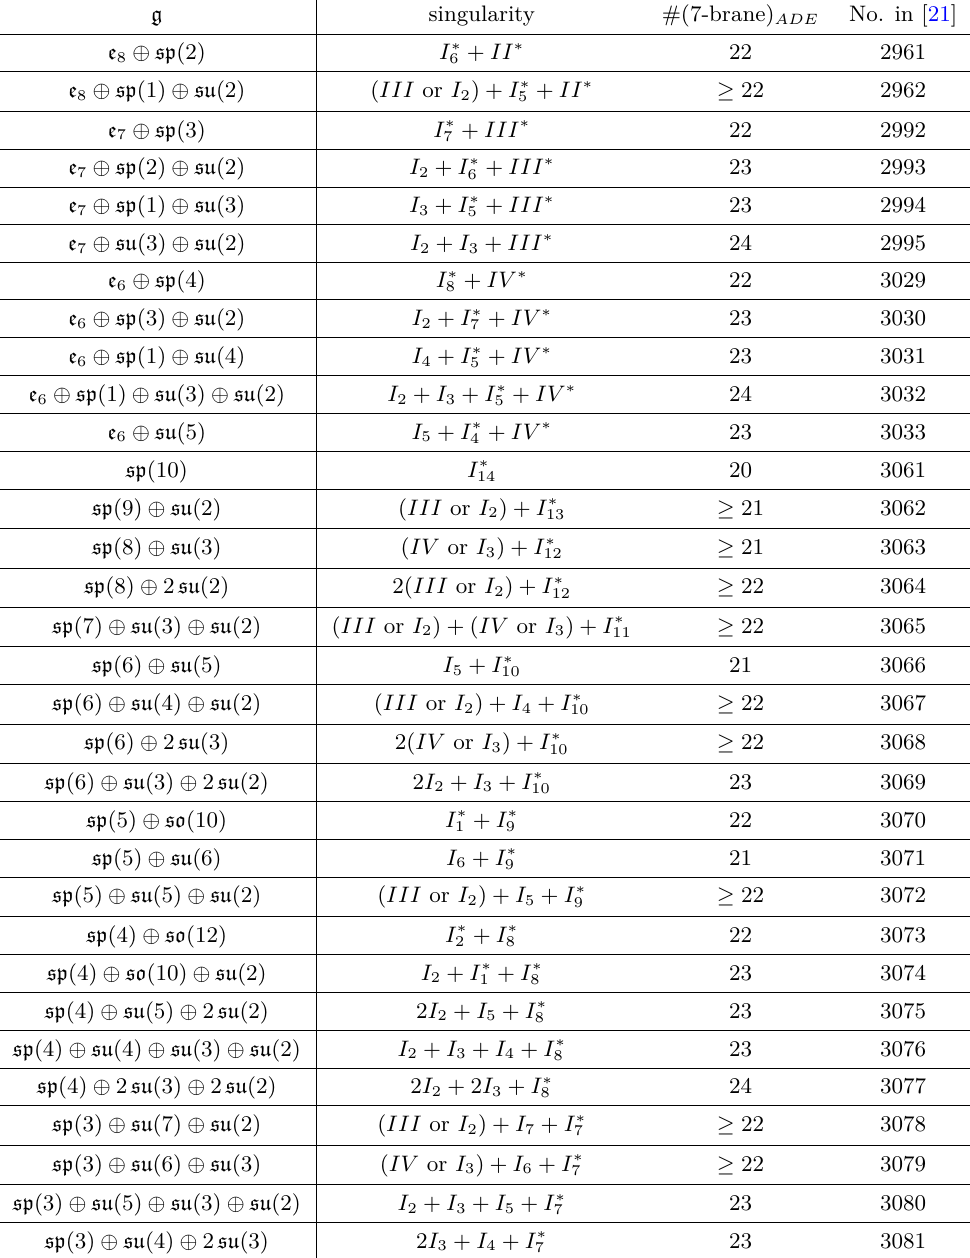
Table 4 . List of Rank = 10 theories realized in string theory (Part 1 / 2 ). According to [23], O 7 + plane plus n 7 -brane is described as the frozen I ∗ singularity in F-theory, and gives rise to sp ( n ) n +4 symmetry. By using a list of singularities in [21], we obtain tables 4, 5 and 7. The correspondence with table 1 in [21] is shown in last